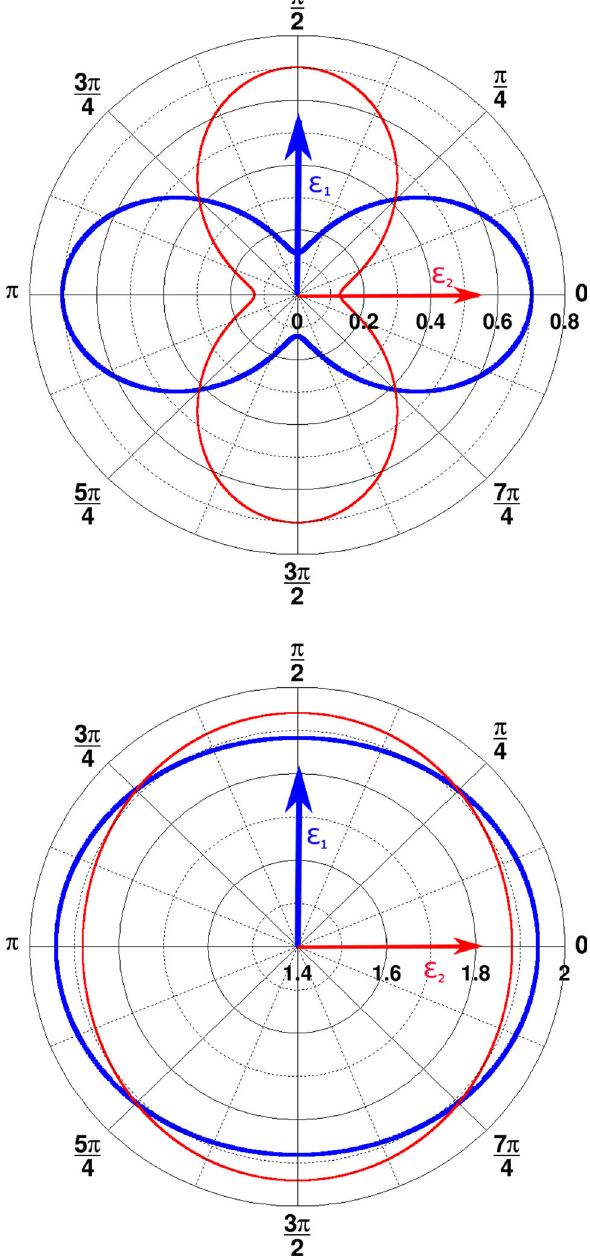
Fig. 8 Radial plots of Klein–Nishina cross sections for 511 keV pho- tons with polarization vectors (cid:2) 1 (thick blue line) and (cid:2) 2 (thin red line), orthogonal to each other. Values given in radians in the plot indicate angle η . The values of cross sections for a given η angle correspond to thedistancefromthecenteroftheplottothepointontheline.Theupper panelshowsresultsforComptonscatteringangleof θ 1 = θ 2 = 81 . 66 ◦ and the lower for θ 1 = θ 2 = 10 ◦